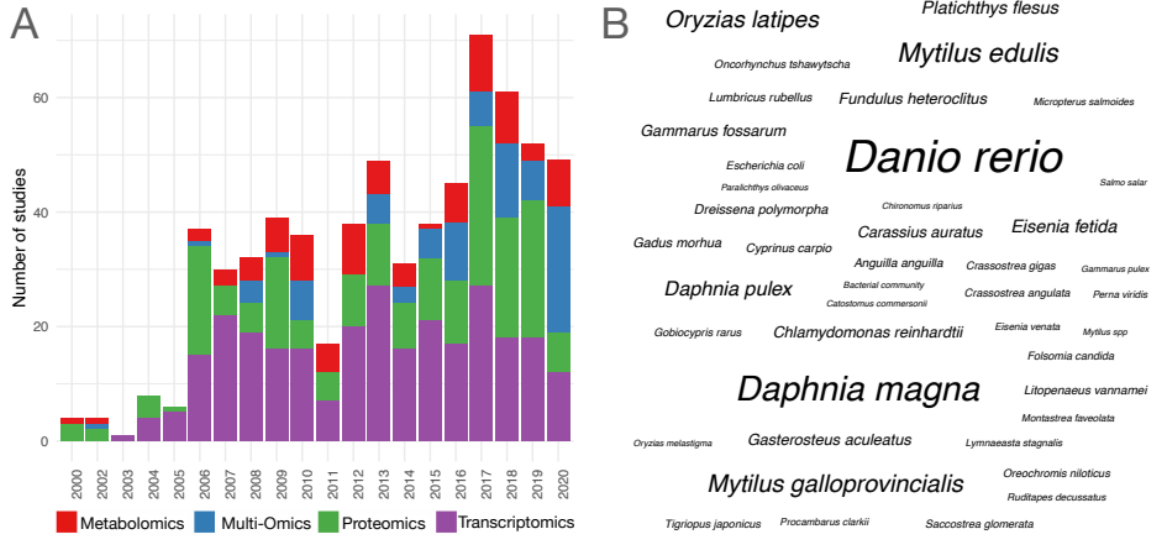
Figure 1. ( A ) Ecotoxicological and stress ecological studies between 2000 and 2020 that used one or multiple omics methods to investigate molecular changes following exposure to (environmental and chemical) stressors. ( B ) Word cloud showing representative model and non-model species studied across all years (only species with n > 2 studies are shown). Word size corresponds to the number of